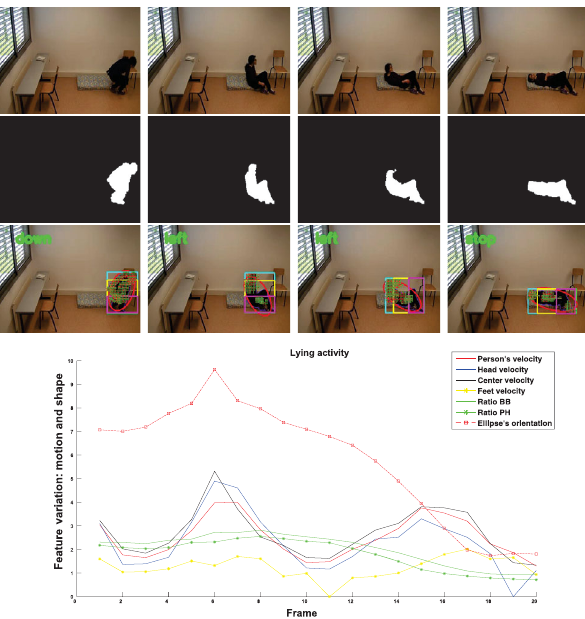
Fig. 15 Lying down activity. Row 1: input frames. Row 2: extracted human silhouettes. Row 3: three blocks representation. Graph: variation in feature values over 20 frames. Table 4 Classification score for different kinds of feature Dataset Shape Motion